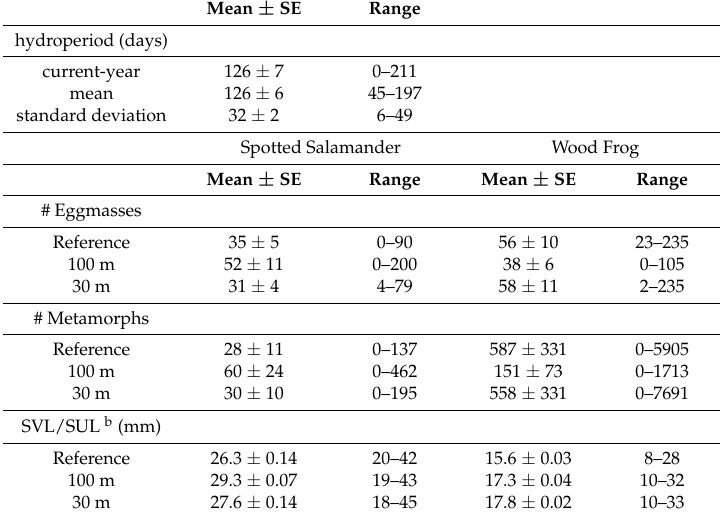
Table 1. Mean and variability for amphibian abundance and pool hydroperiod across the 11 study pools and 6 study years a